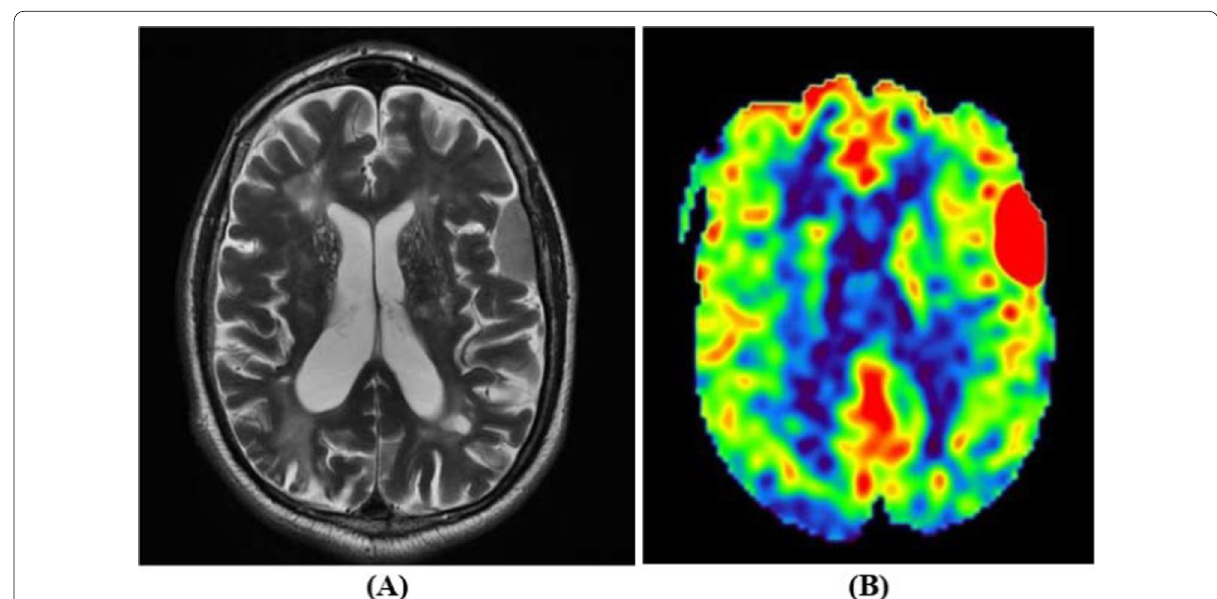
Fig. 6 MRI of hypervascular meningioma: A Axial T2-weighted MRI showing left frontal convexity meningioma. B Color coded ASL perfusion showing hyperperfusion of the lesion with nCBF of 7.4, proved surgically to have high vascularity